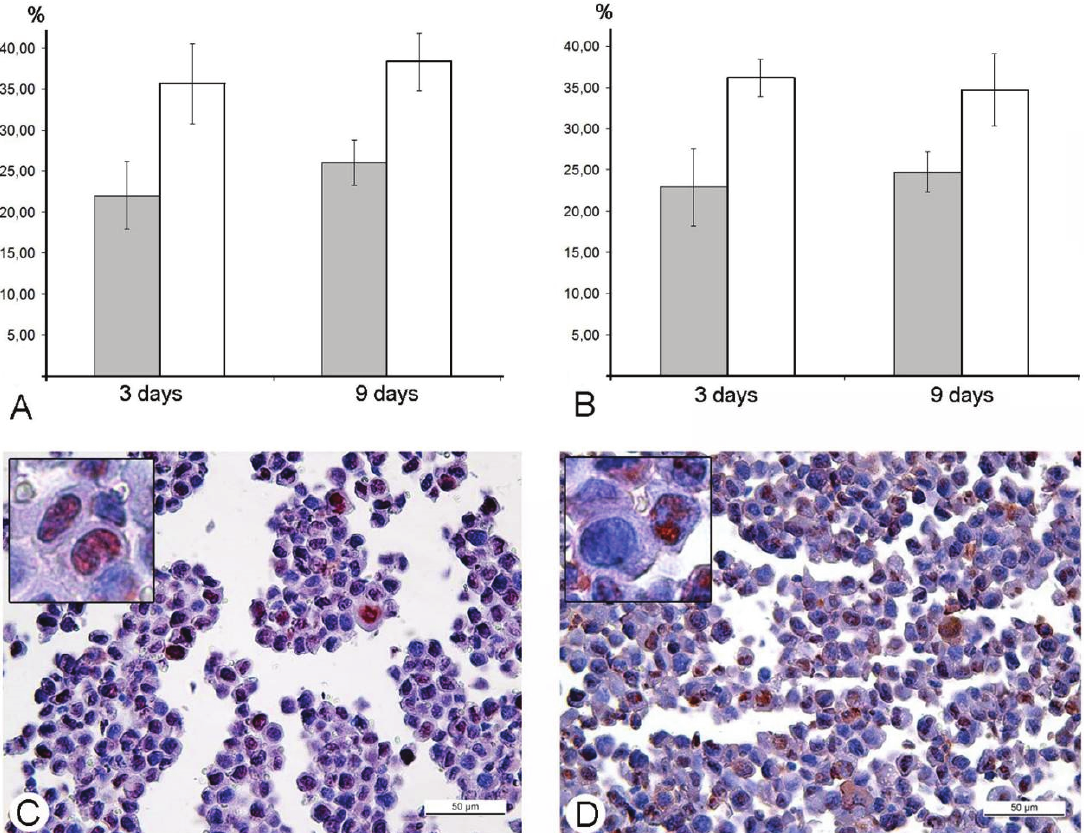
Figure 7. Increase in number of Ki-67 ( A ) and PCNA-positive ( B ) cells in murine Ehrlich ascitic carcinoma in mice treated with the L-IVP strain (white columns) and saline (grey columns). Horizontal line indicates the time after virus injection. Counting was done on paraffin sections, which were stained immunohistochemically at 400-fold magnification. Photos C and D illustrate immunochistochemical staining for Ki-67 ( C ) and PCNA ( D ) in Ehrlich ascitic carcinoma cells, 3 days after injection of the L-IVP strain and saline, respectively. Chromogen AEC, counterstained with hematoxyline.